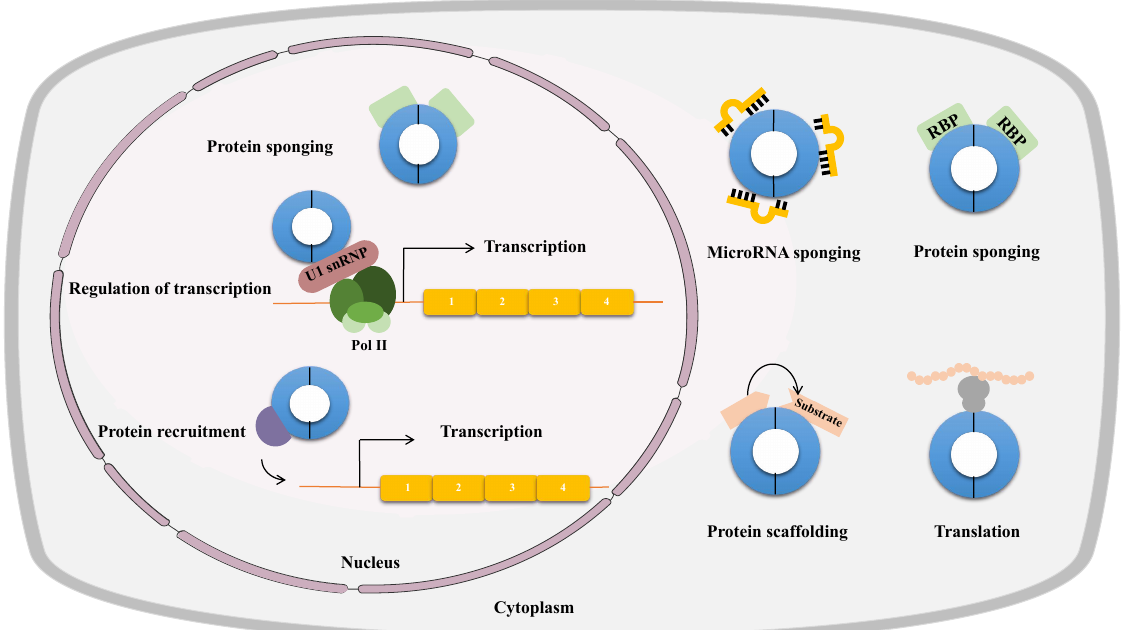
Figure 4. Biological functions of circRNA. CircRNAs function as important gene regulators through multiple actions, including miRNA or protein sponges or decoys, templates for translation, protein scaffolding, and recruitment or enhancer of protein